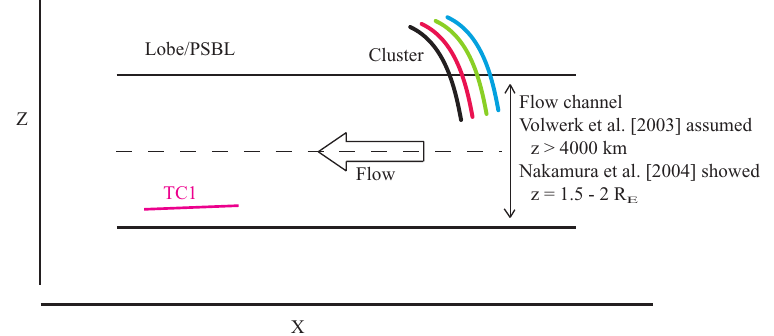
Fig. 6. Schematic view of the spacecraft entering the plasma sheet flow channel. TC-1, remaining on near constant z GSM observes the creation of the flow channel and remains in this channel. The low velocity flow is maintained until after 20:00 UT. Twenty-ninemin later, Cluster has moved in z GSM and enters the flow channel, observing that the magnetic field “dipolarizes” and the plasma